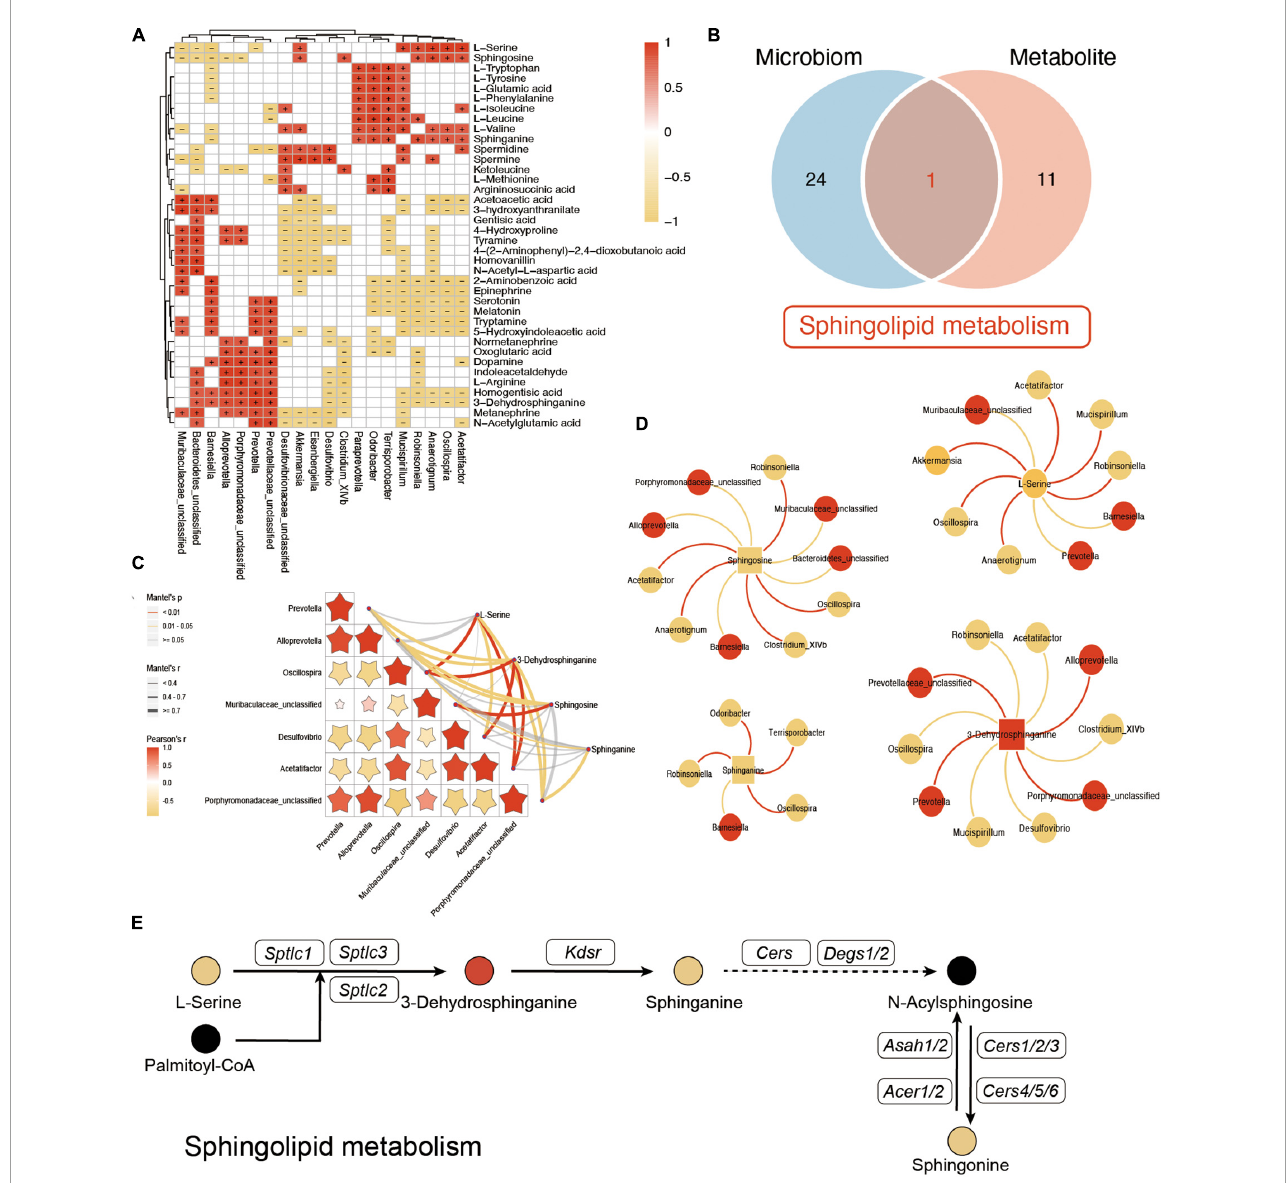
FIGURE7 Integrated analysis between microbiome and metabolites. (A) The Spearman correlation analysis between the significantly changed microbiome and metabolites. + and – indicate the significant positive and negative association, respectively. (B) Venn diagram of significant differential KEGG pathways in functional analysis of gut microbiota and the metabolic pathway based on the metabolites. (C,D) Mantel’s analysis and interaction network plots of enriched metabolites in the shared pathways with microbes that participate in its metabolism. Red colors indicate significantly upregulated metabolites or microbes, while yellow colors indicate significantly downregulated metabolites or microbes. Red and yellow lines indicate the positive correlation and negative correlation, respectively. (E) Illustrative example of metabolite changes in the sphingolipid metabolism